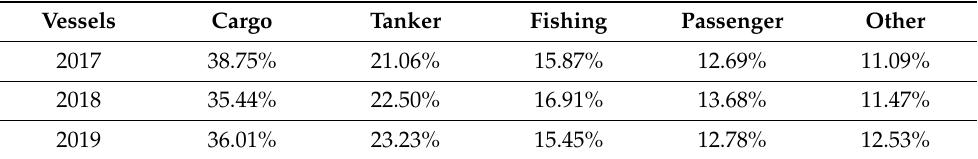
Table 1. Contribution of each category (in %) to the total vessel density by the EMODnet database for the Mediterranean and the Black Sea